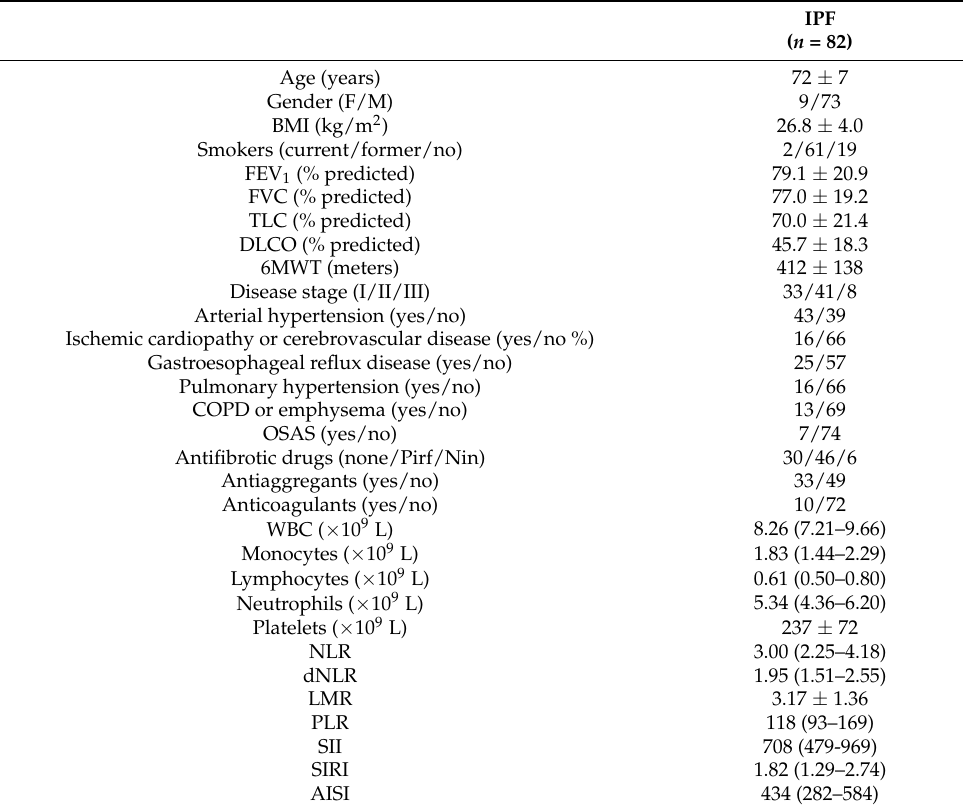
Table 1. Demographic, clinical, and haematological characteristics of IPF